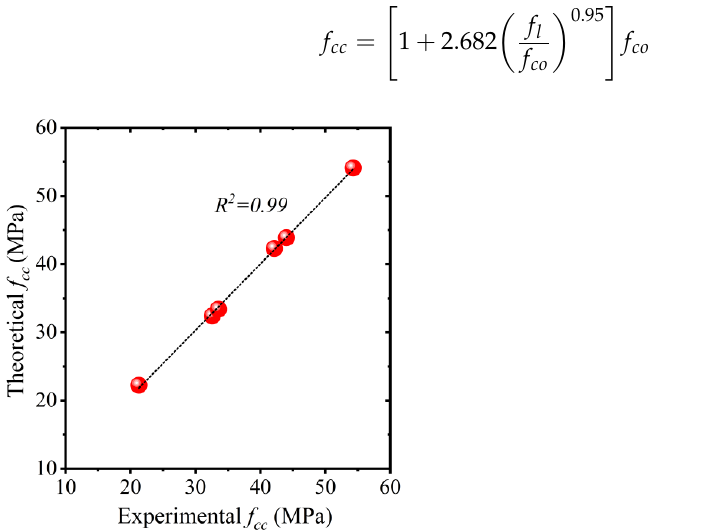
Figure 16. Comparison of experimental vs. predicted compressive strength of hemp-confined concrete.